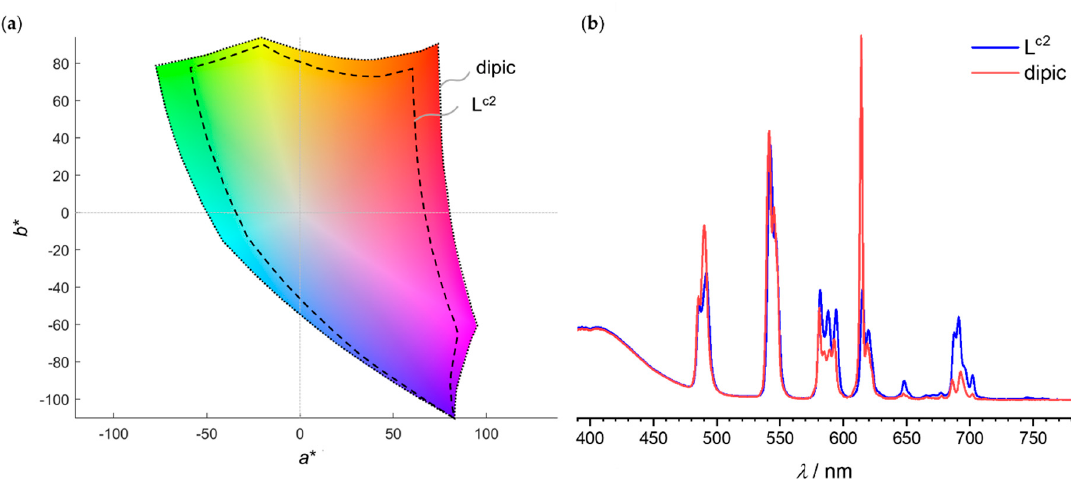
Figure 8. ( a ) Overlapping gamuts of the dipic and L c2 sets with the white points matched to have the same luminance Y and to have the same chromaticity as a D65 illuminant. ( b ) Corresponding white relative spectral irradiances where all the primaries of the L c2 set were scaled by a factor of 0.6989 in order to match the luminance of the dipic white spectrum.